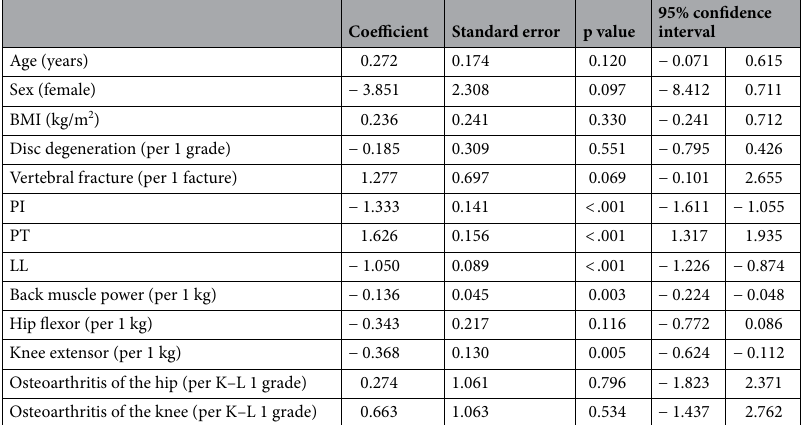
Table 3. Association between thoracic kyphosis and subjects with PI-LL mismatch > 10° using a multivariate linear regression model. The linear regression model was adjusted for age, sex, body mass index, the total disc degeneration, PI, LL, PT, back muscle strength (per 1 kg), hip flexor strength (per 1 kg), knee extensor strength (per 1 kg) and osteoarthritis of the hip and knee (per K–L 1